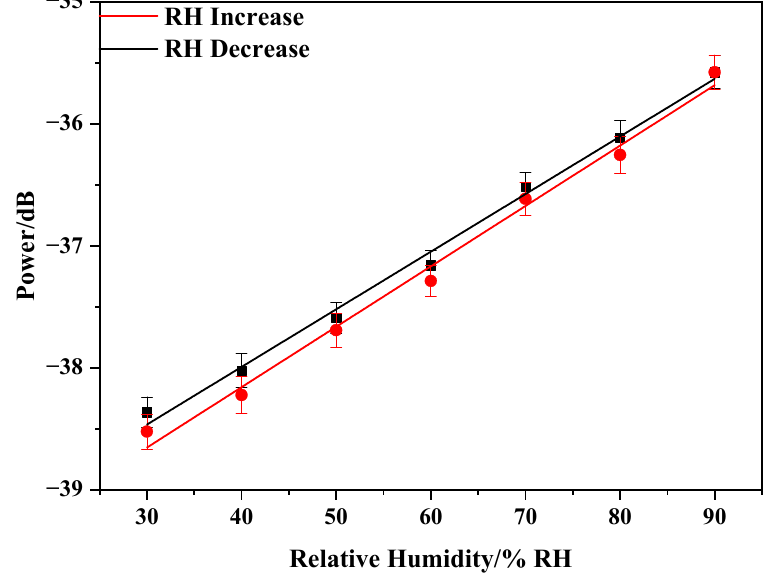
Figure 11. PVA/CNTs composite nanofiber film humidity fitting curve.